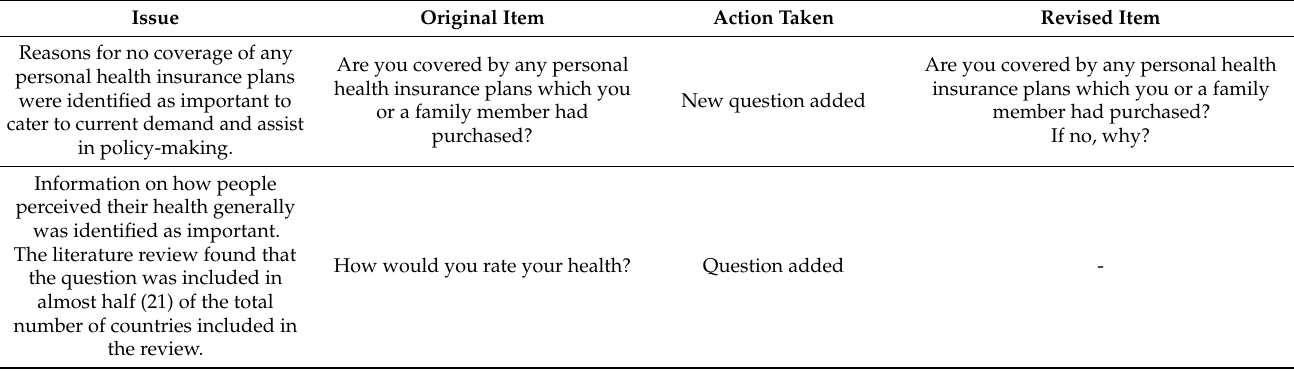
Table 3. Examples of action taken based on results of the qualitative testing. Issue Original Item Action Taken Revised